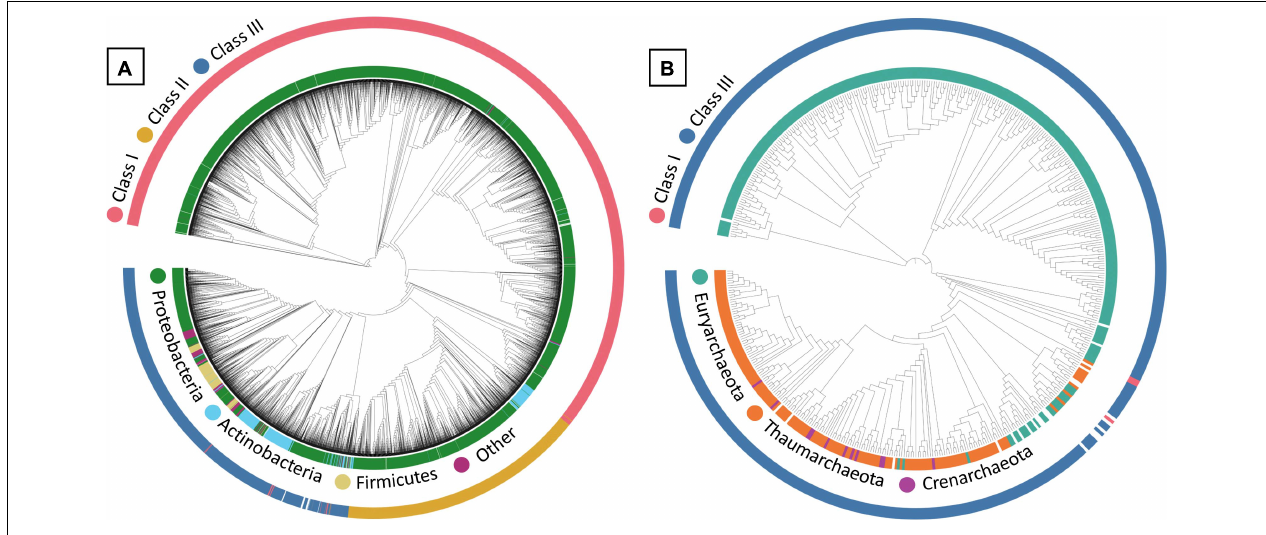
FIGURE 1 | Maximum-likelihood tree of (A) bacterial and (B) archaeal PHA Synthase protein sequences. Sequences include both UniprotKB query sequences and BLAST identified sequences from IMG genomes. Uncolored strip sections indicate unclassified data. Created using Interactive Tree of Life